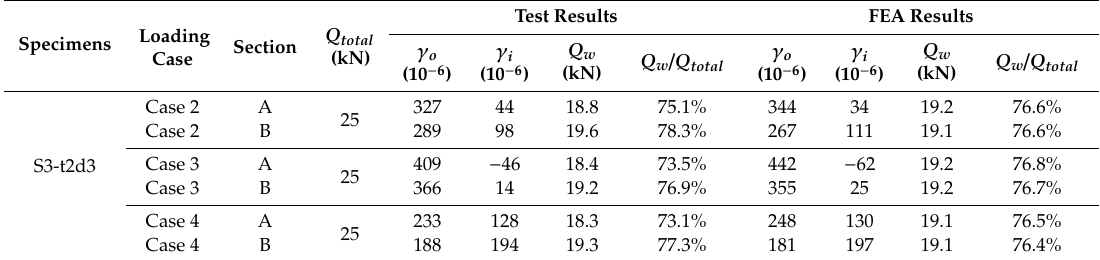
Table 13. Ratios of Q w to the total shear force Q total of specimen S3-t2d3.